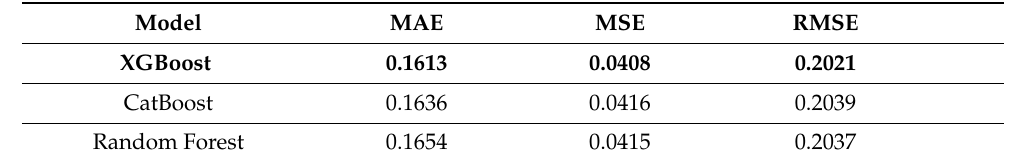
Table 3. Regression model metrics—using remote sensing features.